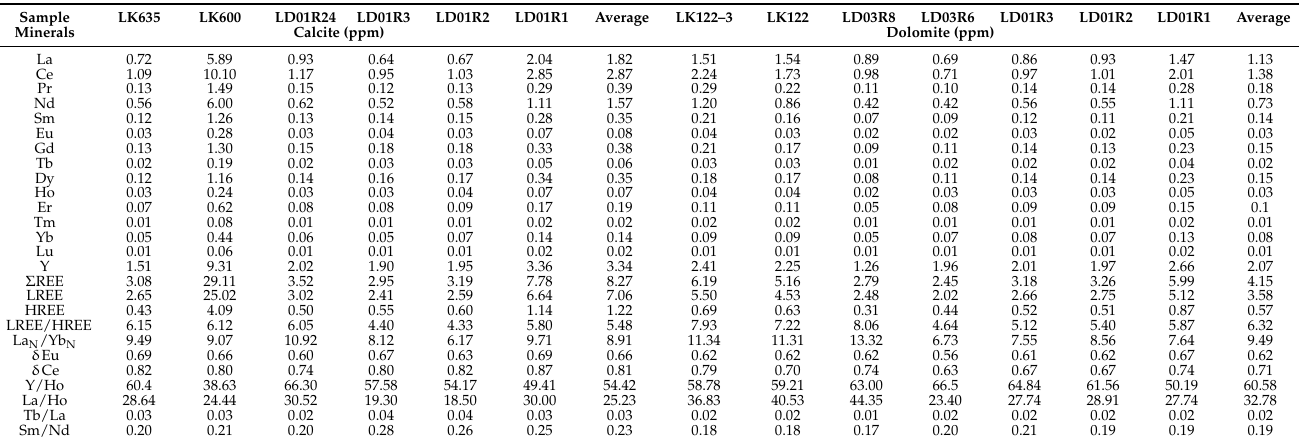
Table 1. Analysis results of REE contents of hydrothermal calcite/dolomite samples from the Lekai Pb-Zn deposit.